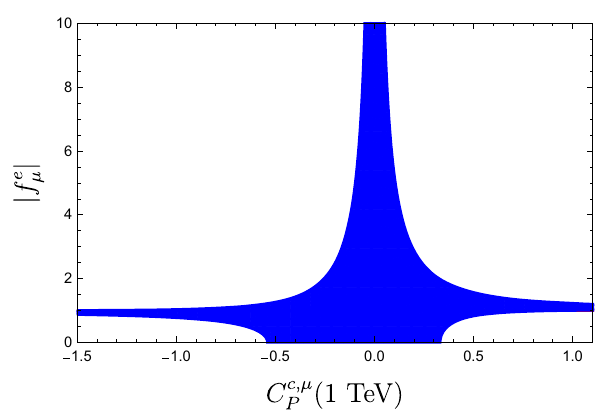
,μ and the P as P